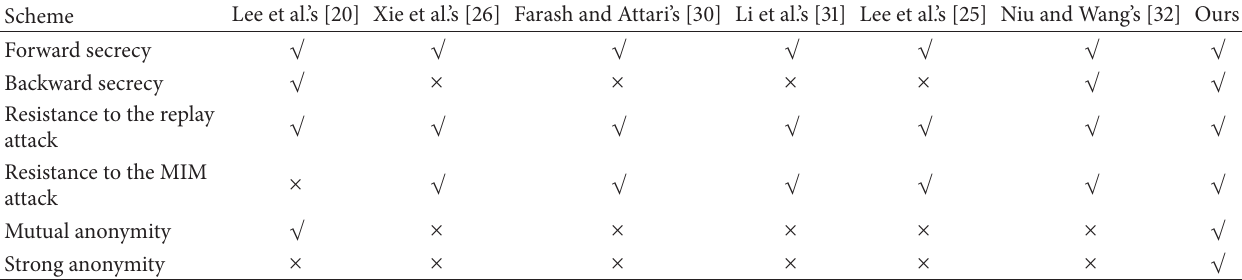
Table 1: Comparison of